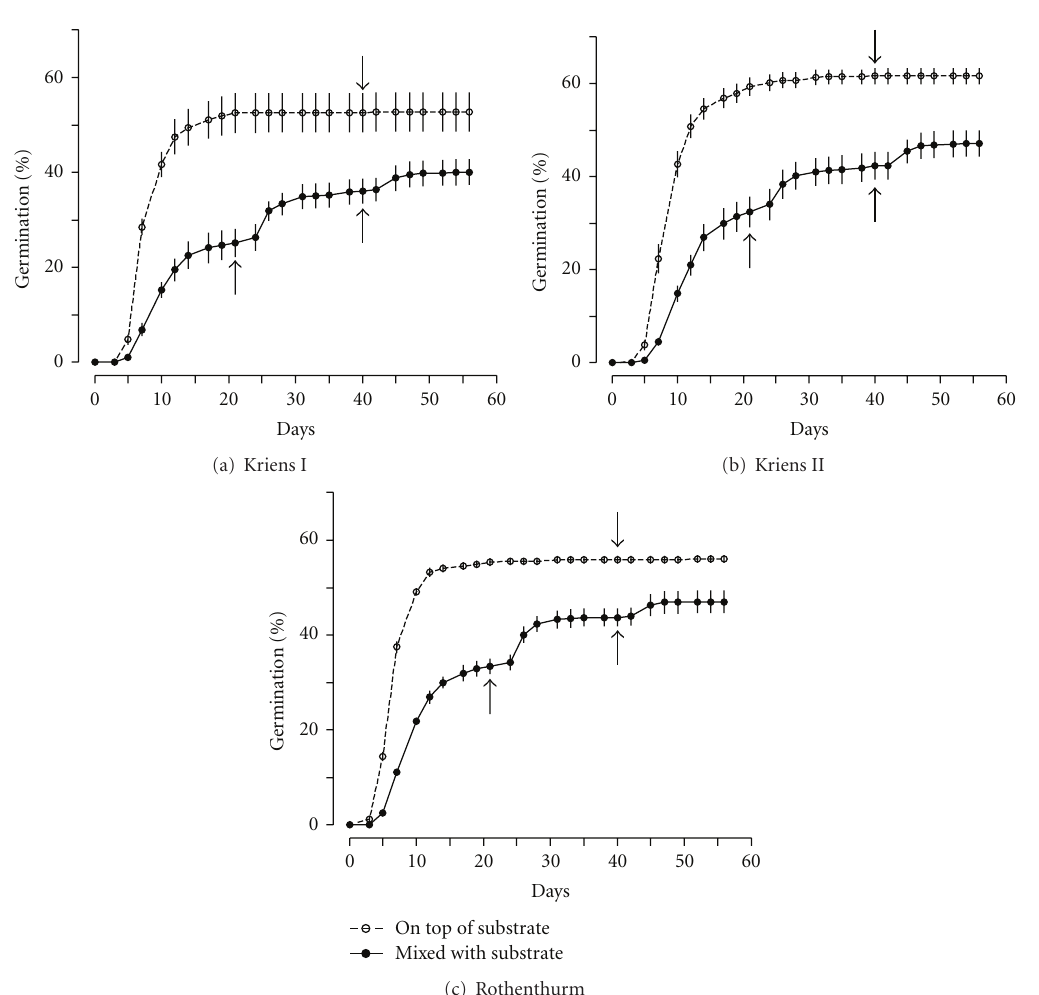
Figure 3: Germination percentages of fresh ripe seeds of Senecio aquaticus sampled in 2010; displayed are means ± SE ( n = 5). For germination, seeds either lay on top of or were mixed with substrate that was spread in 5mm thick layers. At noted dates ( ↓ , ↑ ) substrate was thoroughly crumbled to provide light to all seeds.